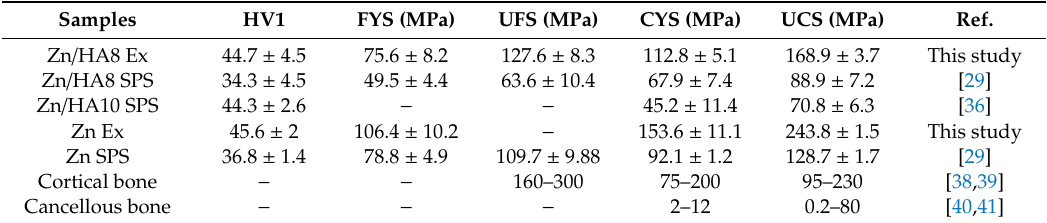
Table 3. Overview of the mechanical properties of composites with di ff erent content of HA and pure zinc processed by various